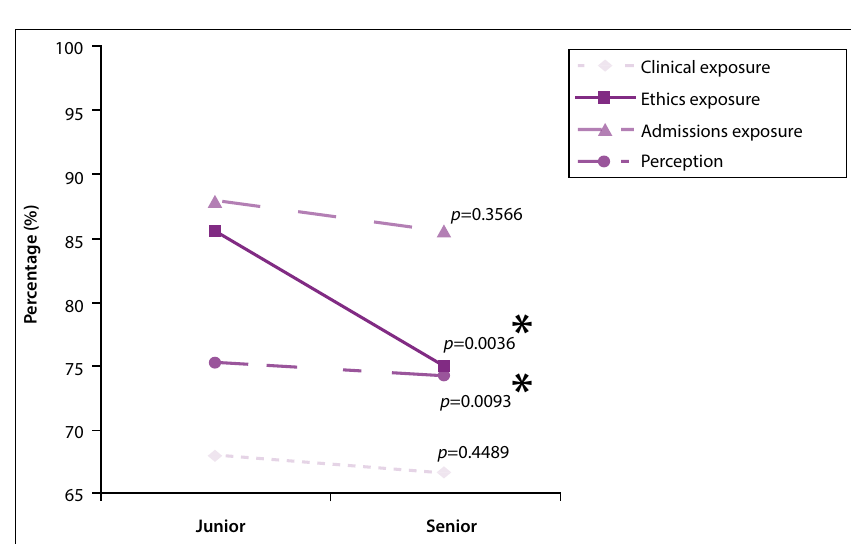
Fig. 6. Scores by seniority (5th or 6th year of study) as a percentage. (*Statistically significant